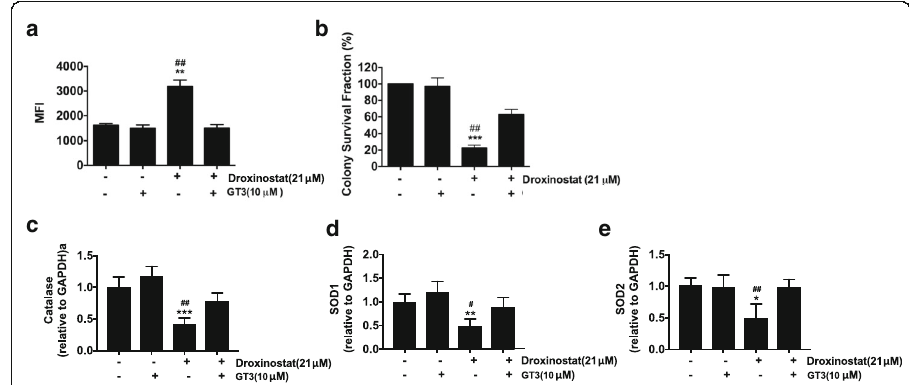
Fig. 4 GT3 pretreatment blocked oxidative stress induced by droxinostat treatment in colon cancer cells. a – HT-29 cells were treated with GT3 followed by droxinostat treatment for 24 h. ROS production was measured using DCFDA and analyzed via flow cytometry. The levels of ROS are expressed as the means ± SD of three independent experiments. ** p < 0.01 vs. vehicle, ## p < 0.01 vs. GT3. b – 500 HT-29 cells were seeded in 6-well plates and treated with or without GT3 and droxinostat. Ten days later, the colony numbers were counted and are expressed as the colony survival fraction. *** p < 0.001 vs. vehicle, ## p < 0.01 vs. GT3. C through E – HT-29 cells were treated with GT3 followed by droxinostat treatment for 24 h, and RNA was extracted to measure the expressions of catalase ( c ), SOD1 ( d ) and SOD2 ( e ) via RT-PCR. GADPH was used as a housekeeping control. * p < 0.001 vs. vehicle, ** p < 0.001 vs. vehicle, *** p < 0.001 vs. vehicle,